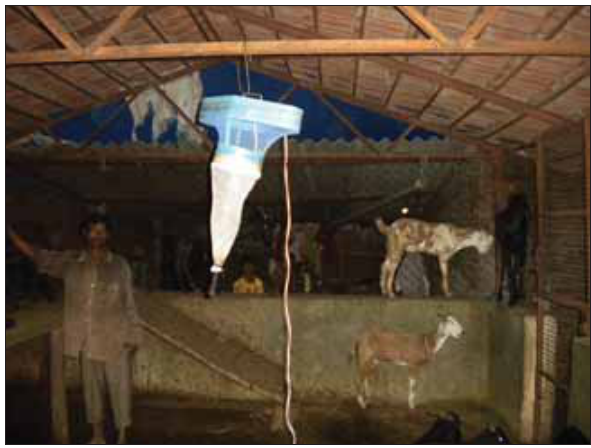
Figure-2: Light tap collections of Culicoides spp. and other flies in goat